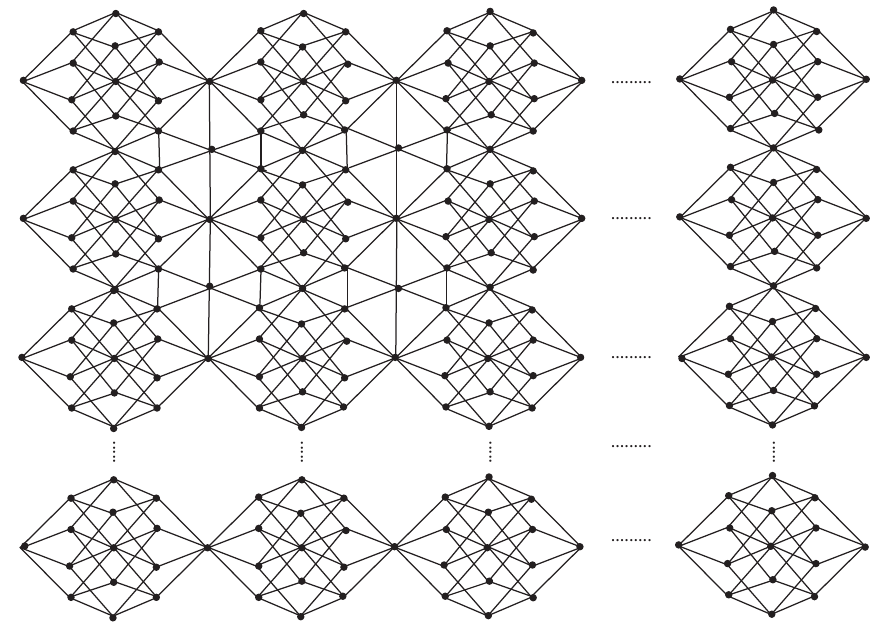
Figure 1: Robertson apex